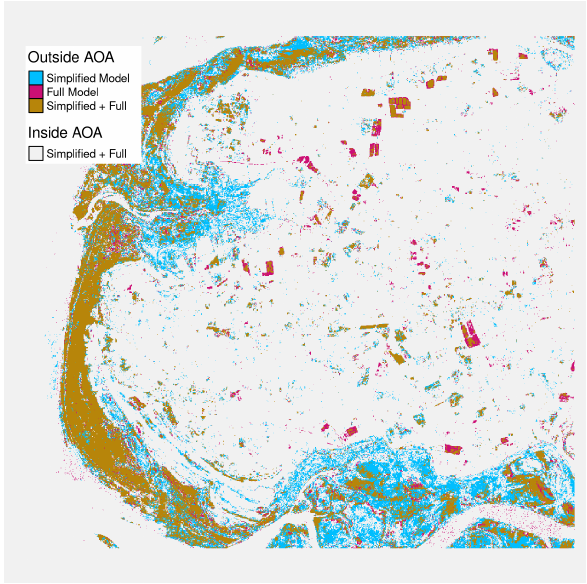
Figure 5. Area of